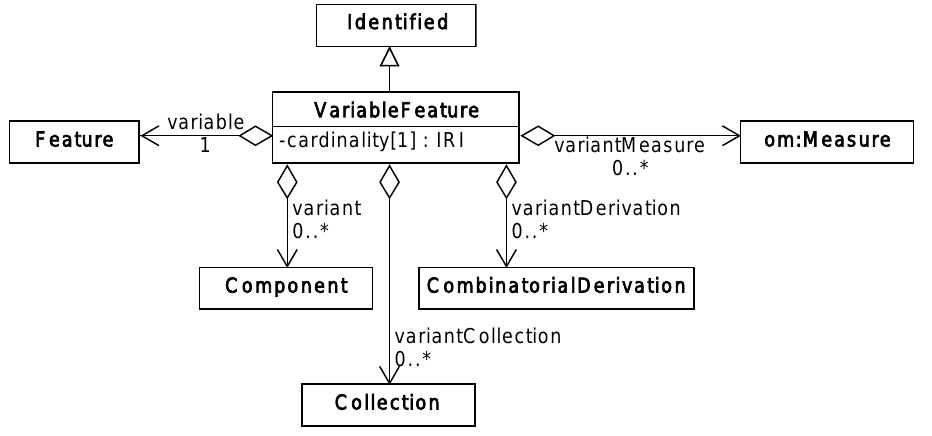
Figure 16: Diagram of the VariableFeature class and its associated